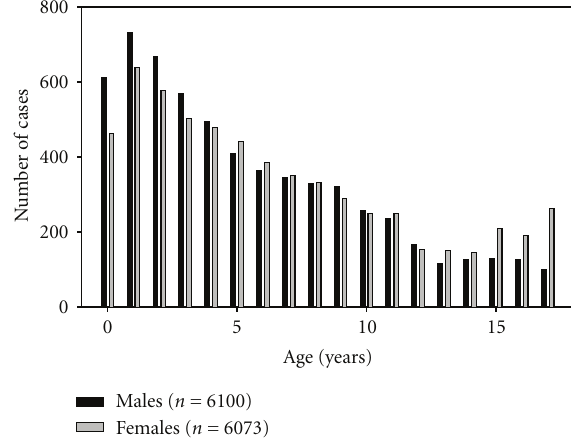
Figure 1: Age distribution (in years) in male and female subjects between 1 and 18 years.